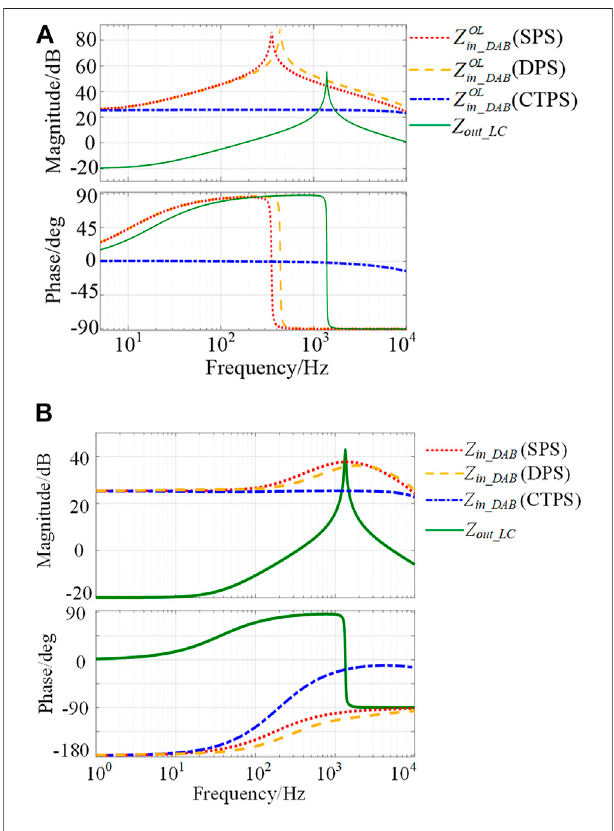
FIGURE 6 | (A) Bode plots of open-loop input impedances of DAB converters. (B) Bode plots of closed-loop input impedances of DAB converters.